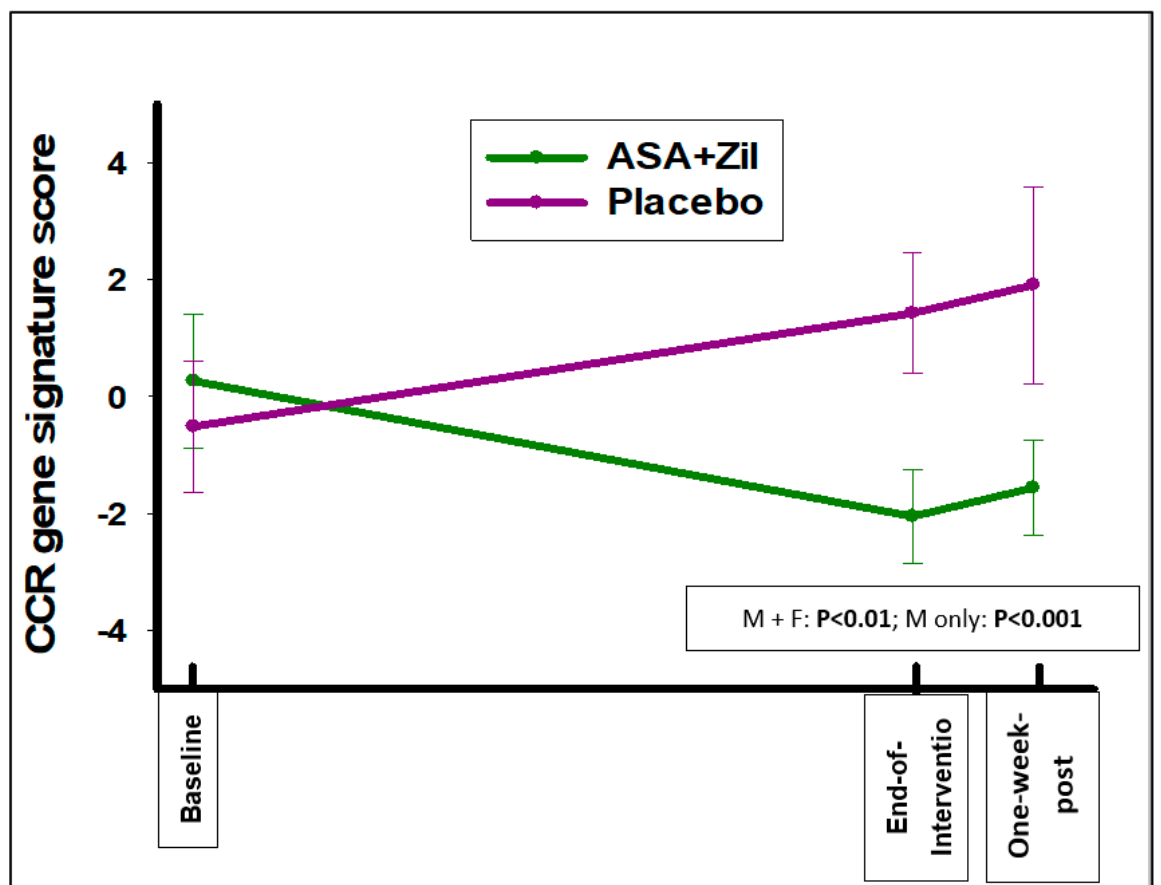
Figure 2. Bronchial dysplasia signature score at the baseline, end-of-intervention, and one-week post-intervention time points (pos → neg z-score is in the favorable direction)